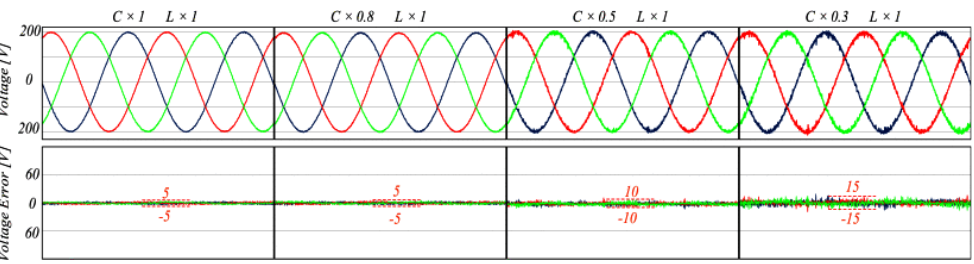
Figure 25. Performance of model-based predictive control.